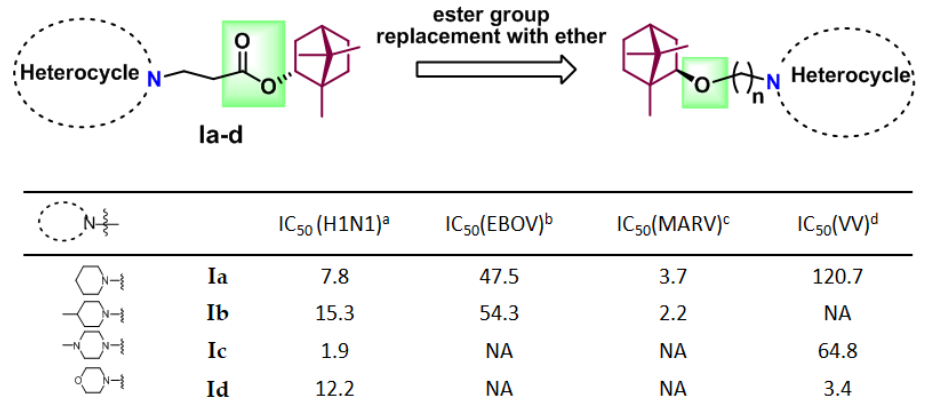
Figure 1. Structures of (−)-borneol-based antiviral agents and illustration of the strategy used for structure-activity relationship studies in the present work. a IC 50 (H1N1) 50% inhibitory concentration against influenza virus A/Puerto Rico/8/34 (H1N1) [10]; b IC 50 (EBOV) 50% inhibitory concentration against Ebola virus (EBOV) (strain Zaire); c IC 50 (MARV) 50% inhibitory concentration against Marburg virus (MARV) (strain Popp) [12]; d IC 50 (VV) 50% inhibitory concentration against vaccinia virus (VV) [13].